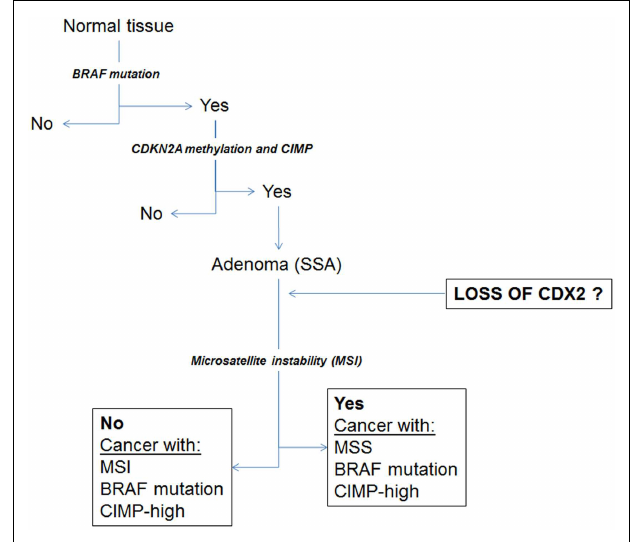
FIGURE 3 | Schematic diagram illustrating a proposal for the involvement of Cdx2 during progression of cancers through the serrated pathway